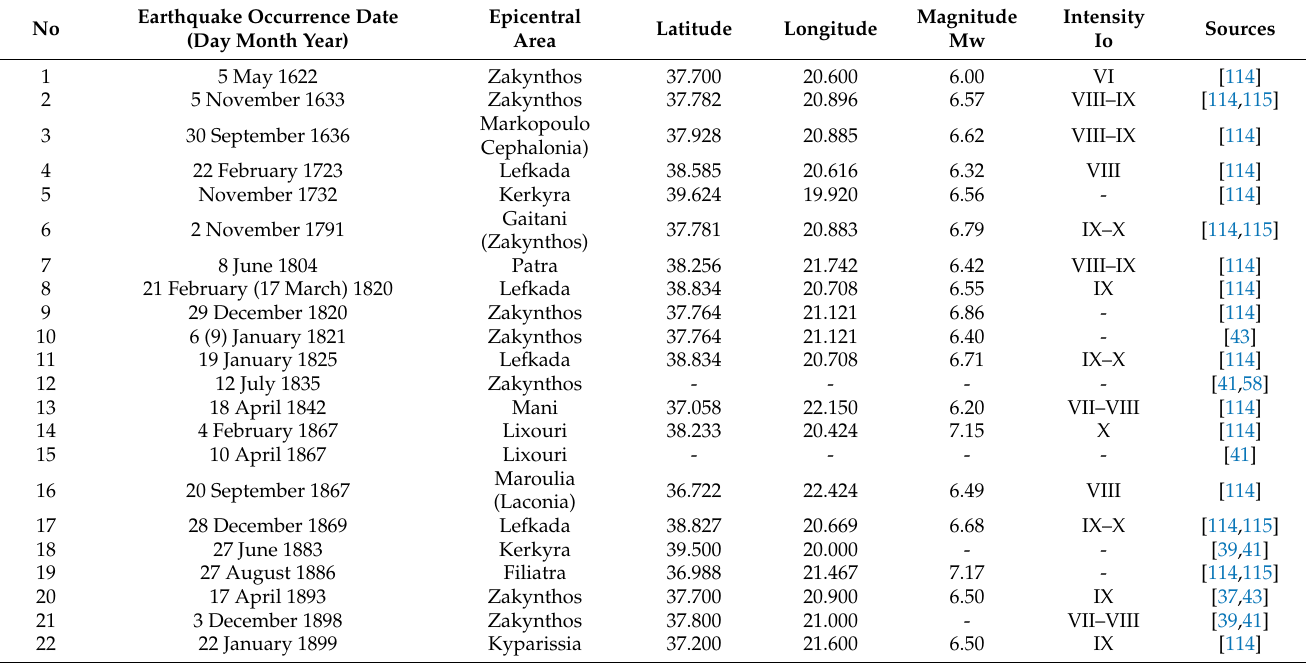
Table 1. Properties of the historical earthquakes (before 1900) that triggered sea disturbances, includ- ing tsunamis, in the Ionian Sea and offshore western and southern